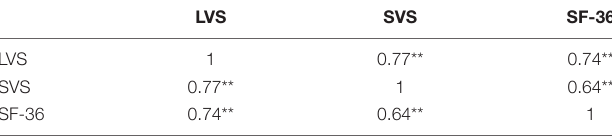
TABLE 5 | Convergent validity of the LVS.